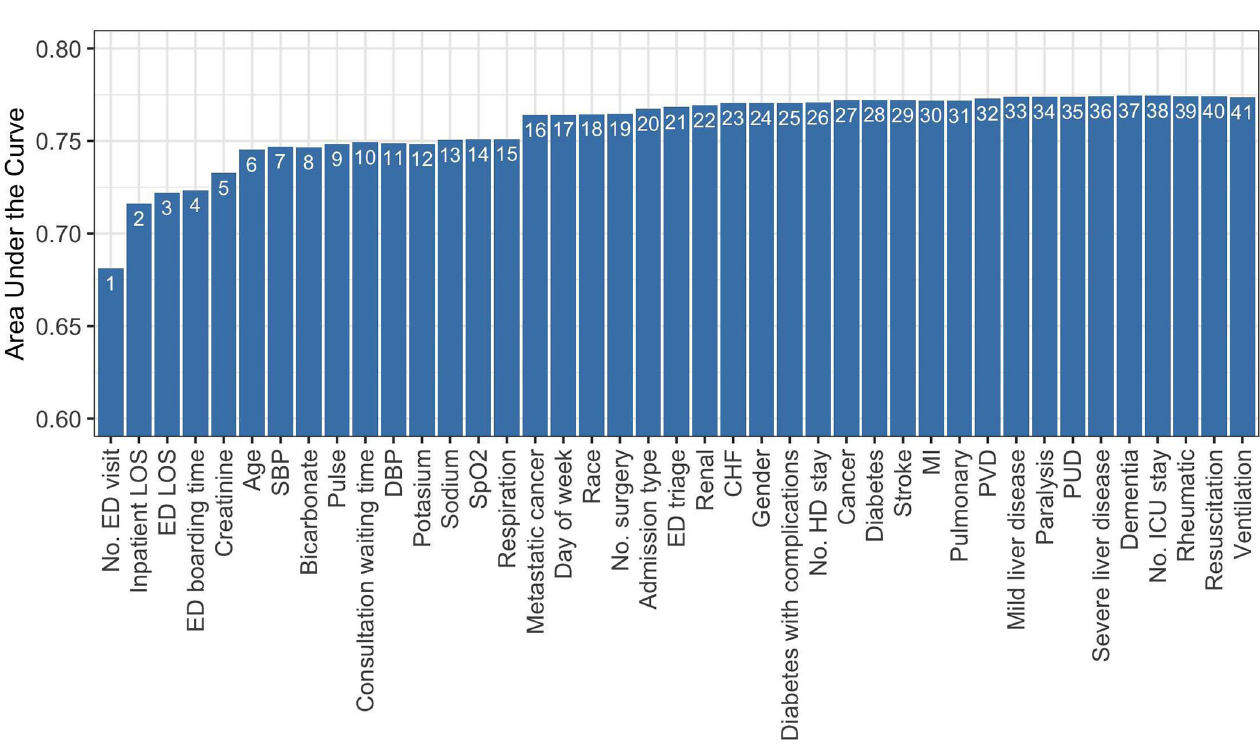
Fig 1. Parsimony plot on validation set using random-forest-based variable ranking. Number of ED visit is within 6 months before current inpatient stay. Number of surgery, ICU stay and HD stay are within 1 year before current inpatient stay. CHF: Congestive heart failure; DBP: diastolic blood pressure; ED: emergency department; HD: high dependency ward; ICU: intensive care unit; LOS: length of stay; MI: Myocardial infarction; PVD: Peripheral vascular disease; PUD: Peptic ulcer disease; SBP: systolic blood pressure; SpO 2 : blood oxygen saturation.